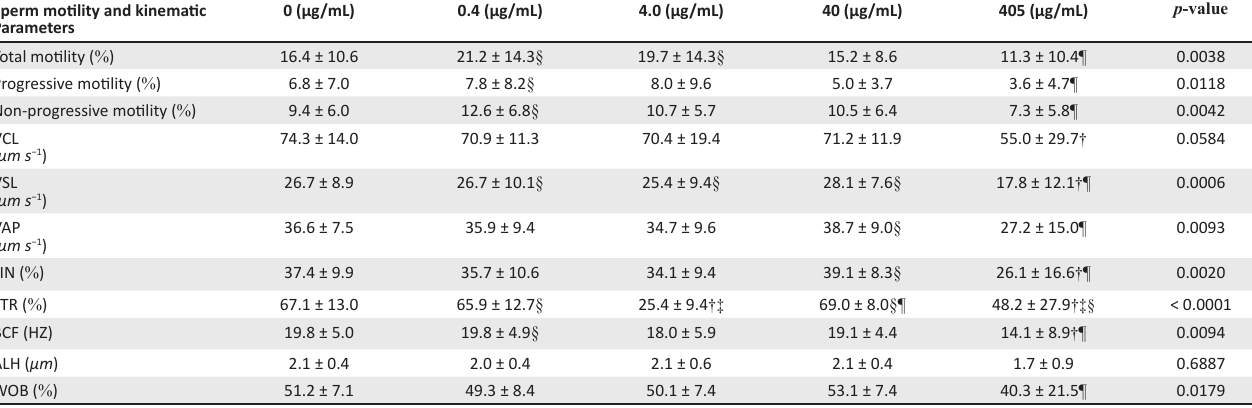
TABLE 2: Effect of green tea aqueous extract on sperm motility and kinematic parameters. Sperm motility and kinematic